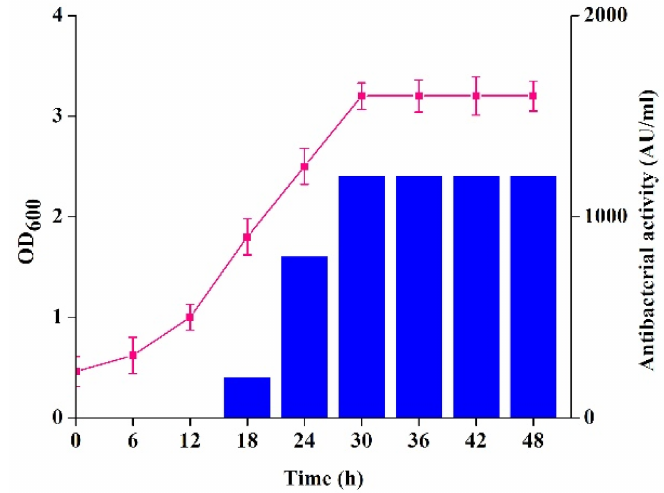
Figure 1. Production of bacteriocin by strain XN2. Square: growth of strain XN2; column: antibacterial activity of the CFS of strain XN2. The data are shown as mean ± standard deviation. The critical limit is 5%. p < 0.05, the differences are significant.